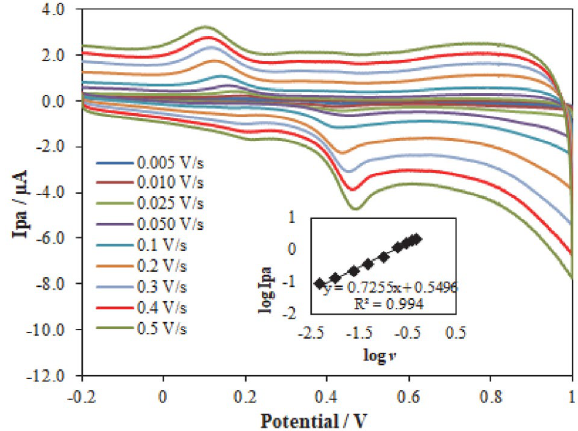
Fig. 5. CVs of 1.0 × 10 –4 molL –1 HQ at different scan rates at NSC modified electrode in 0.04 M BR buffer at pH 2.0 (inset is the plot of log i p vs log υ